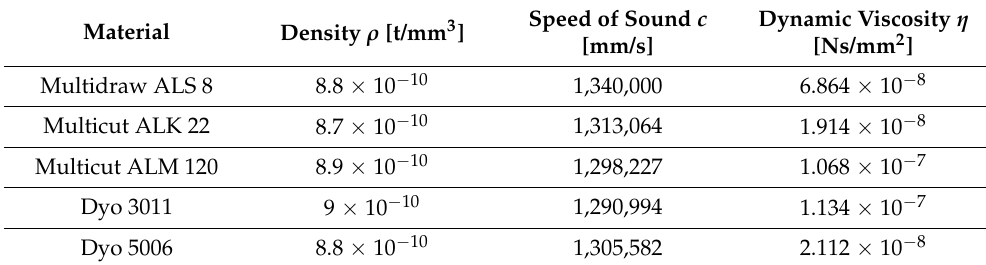
Table 3. Fluid properties according to data sheet and